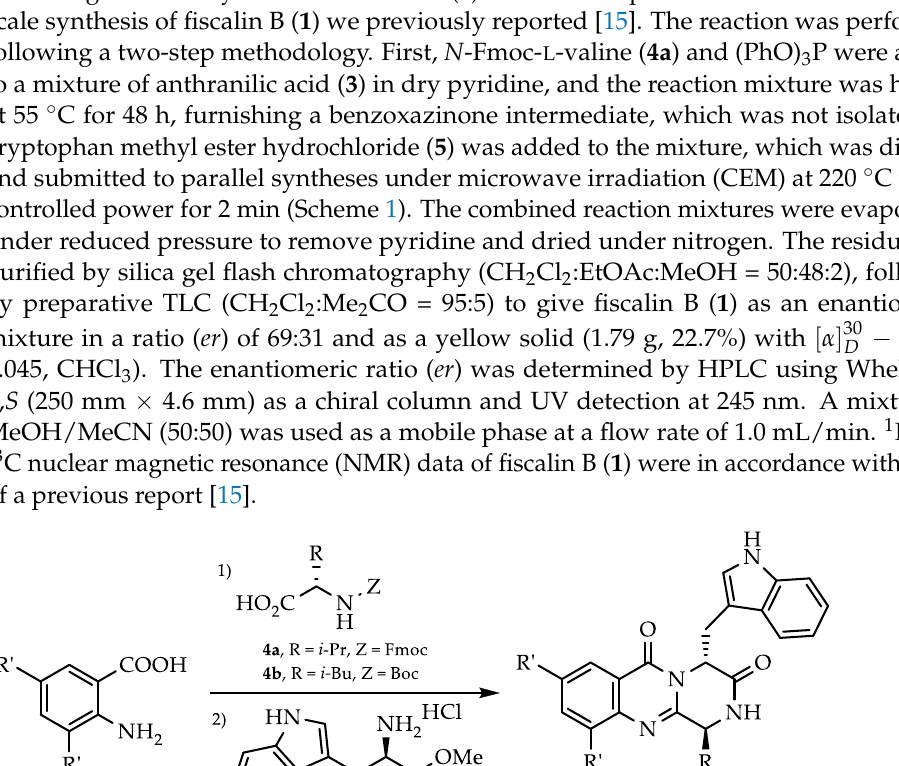
Figure 1. Structures of target compounds for gram syntheses, (1 S ,4 R )-4-(1 H